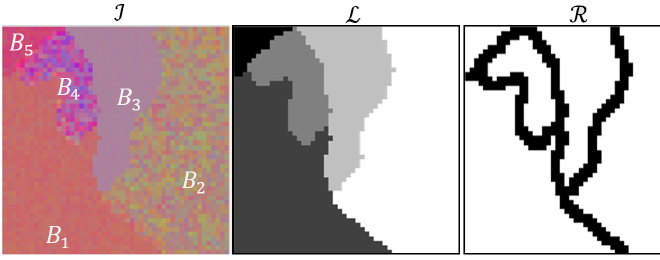
Figure 4. Synthetic RGB image, ground truth and edge